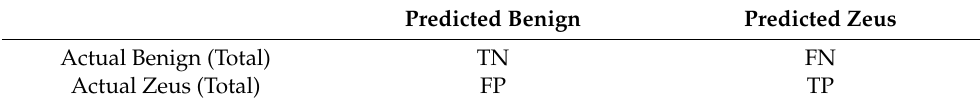
Table 3. An example of the confusion matrix used to measure the detection accuracy. Predicted